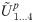
IC-based sequence divergences in the G protein family.The panels show scatterplots of sequences in the G protein alignment along dimensions (U˜1…4p) that correspond to sequence variation in positions contributing to each of the four ICs of the SCA coevolution matrix. The mapping between positional coevolution to sequence relationships is achieved using the reduced alignment matrix x, as per Eqs (14) and (15). Sequences are colored either by annotated functional sub-type of G protein (A-B) or by taxonomic origin (C-D), and the stacked histograms show the distributions of these classifications for each dimension. The data show that ICs 1 and 2 (A) correspond to distinct sequence divergences of functional subtypes of G protein; for example, IC1 separates the Rho proteins (green) along U˜1p, and IC2 separates the Rho proteins (green) and a subset of Ras proteins (red) along U˜2p. In contrast, IC3 and IC4 are homogenous with regard to G protein subtype (B), and all ICs are essentially homogeneous with regard to phylogenetic divergence (C-D). These data suggest that IC3 and IC4 are nearly homogeneous features of the G protein family, while IC1 and IC2 are differentially selected for more specialized properties of G protein subtypes.